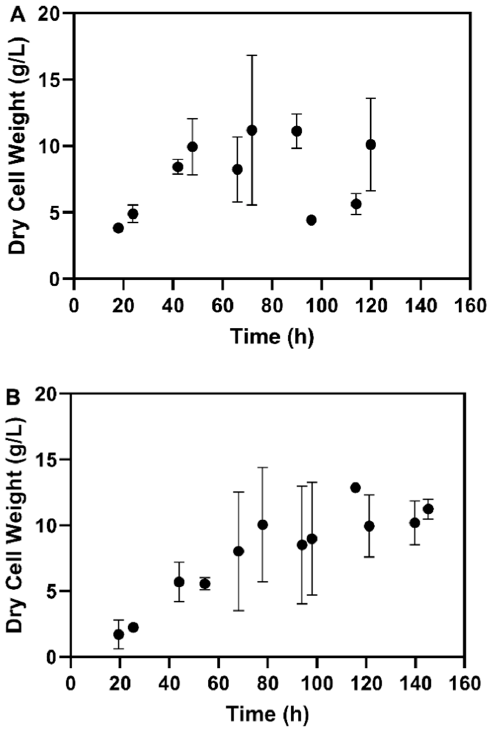
Figure 1. Growth curve profiles for: ( A ) M. circinelloides , and ( B ) M. alpina , grown on glucose in shake flasks.